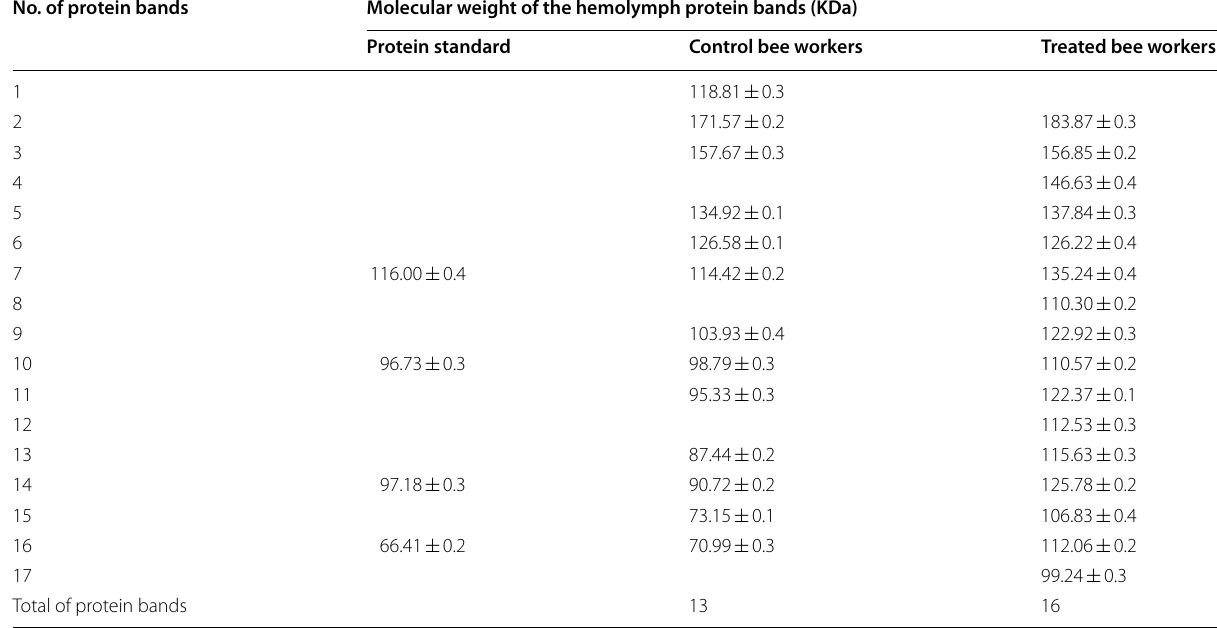
KDa, Unit of kilo Dalton